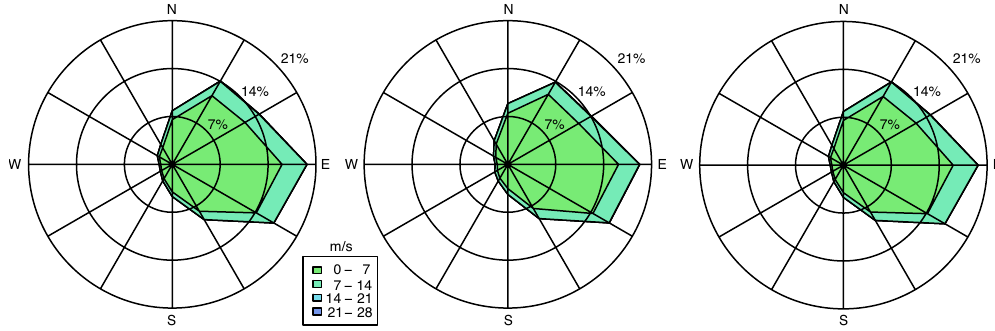
Fig. 3. 10m wind roses derived from 6-hourly 10m winds at Stayky for 20yr of simulation for each of the three climate states. Relevant winds for dust emission are those exceeding the threshold erosion wind speed, 7ms − 1 in this study. Winds below 14ms − 1 are much more frequent than those above 14ms − 1 (which cannot even be seen on the plots), and determine most of the emitted amount of dust (cf. Sima et al.,